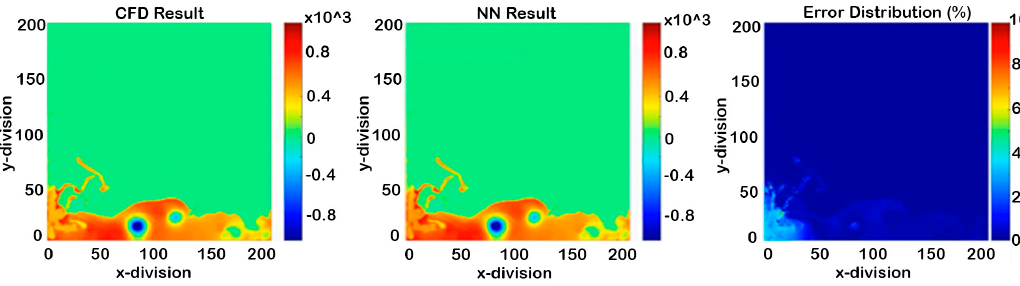
Figure 19. Non-cascading result of X-direction velocity at the maximum error in the whole process (2.604 s).